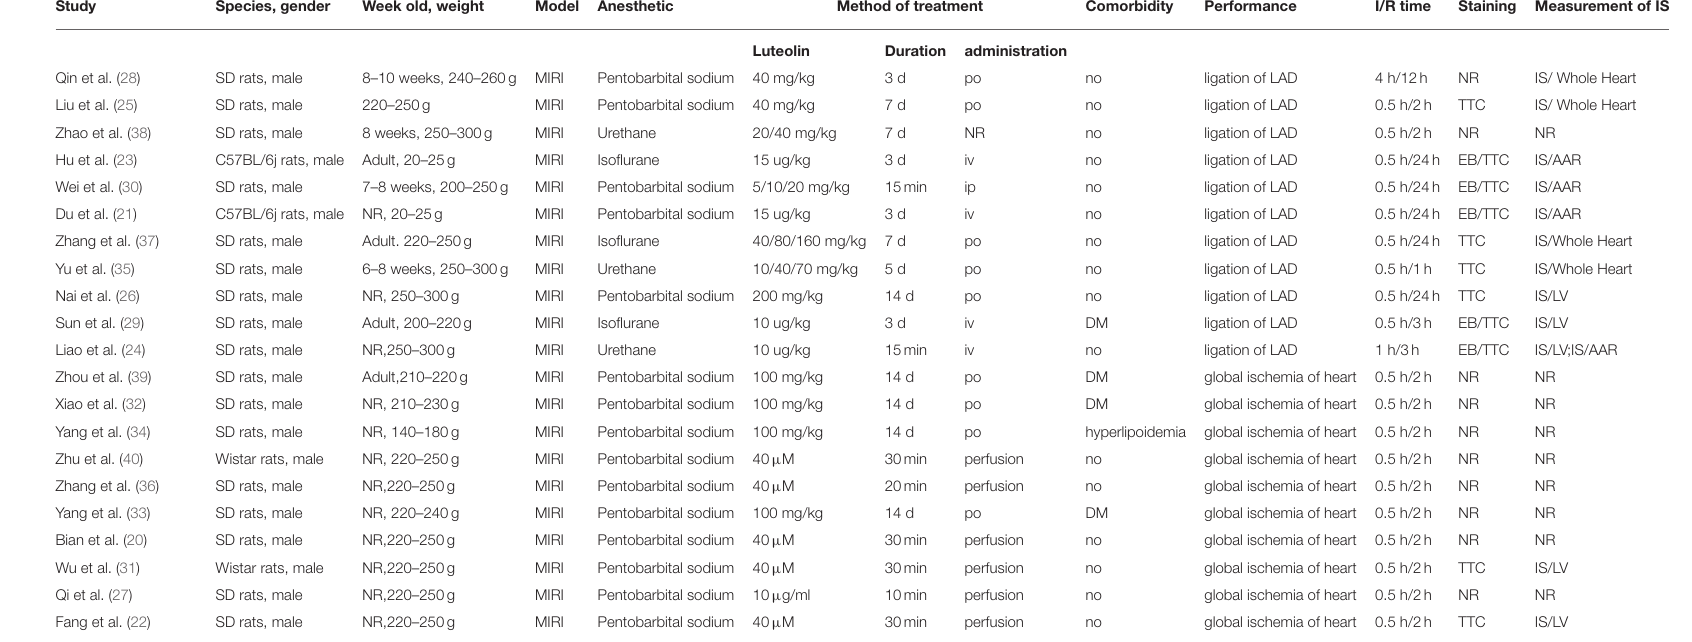
TABLE 1 | Basic characteristics of the included studies.